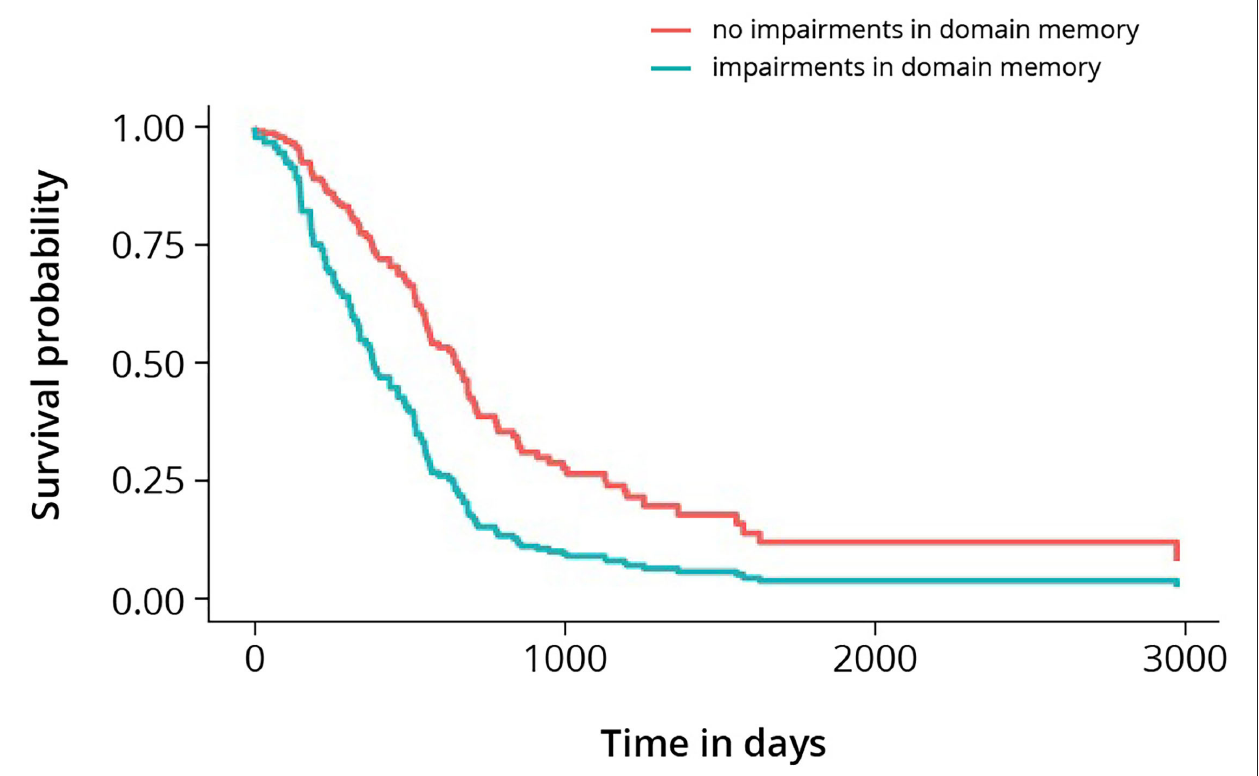
FIGURE 1 | Cumulative survival curves for high-grade glioma, stratified by memory. Log-rank test shows p -value <